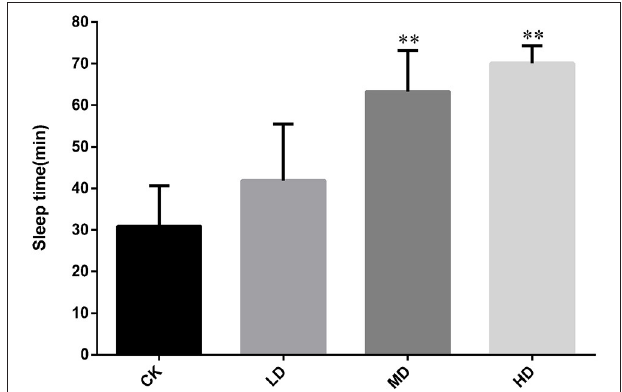
TABLE 1 | Effect of GRAE on the effects of a subthreshold dose of pentobarbital sodium. Group Number of sleeping mice